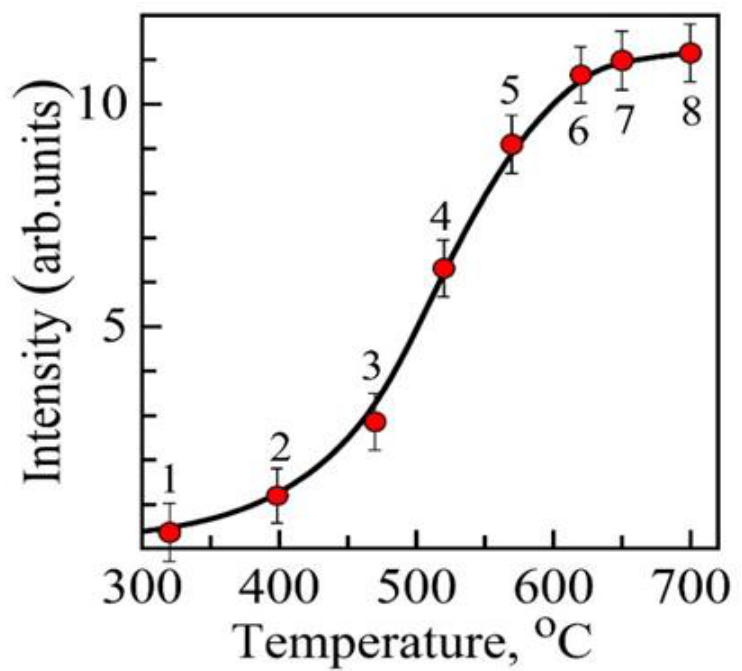
Figure 5. Dependence of the peak intensity of the XRL band at 2.8 eV on the quenching temperature of “decayed” KCl:Na crystals (100 ppm). The quenching temperatures equaled 320 °C (1), 400 °C 470 ◦ C (3), 520 ◦ C (4), 570 ◦ C (5), 620 ◦ C (6), 650 ◦ C (7), and 700 ◦ C (2), 470 °C (3), 520 °C (4), 570 °C (5), 620 °C (6), 650 °C (7), and 700 °C (8).